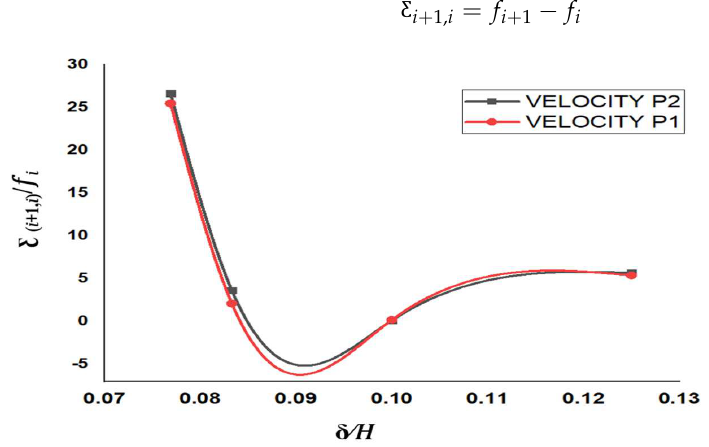
Table 4. Generated data for pressure, shear rate, and velocity from simulation.